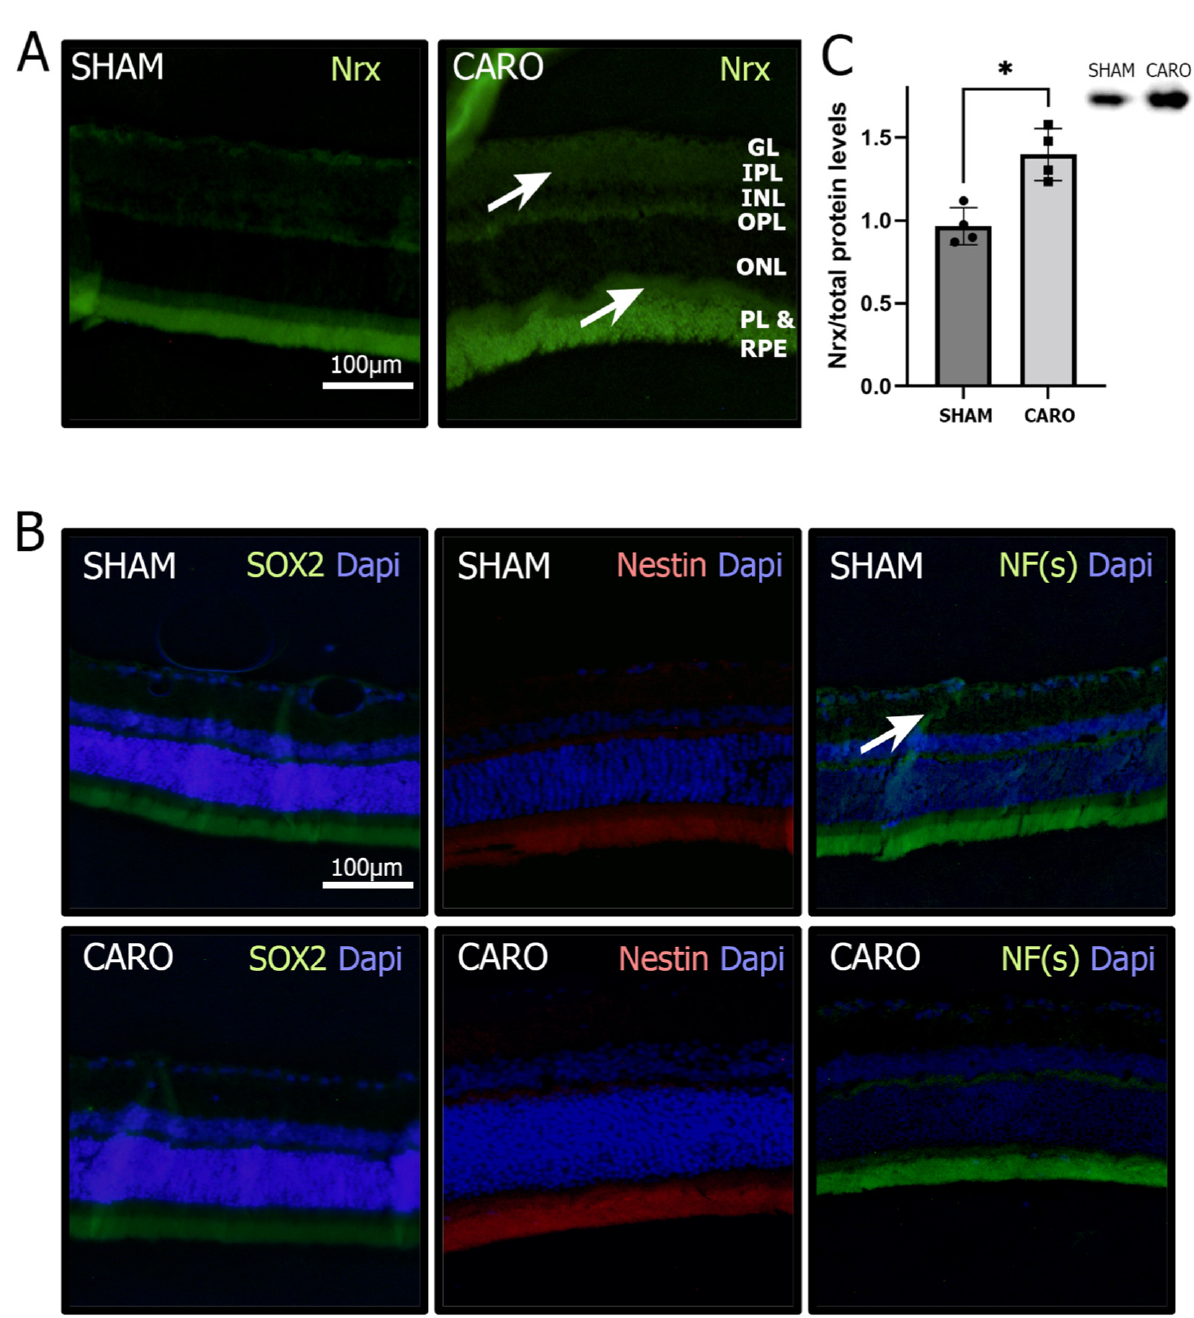
Figure 1. Changes in the retina due to H-I. ( A ). Immunofluorescence staining for Nrx (green) and Dapi counterstaining (blue) in SHAM and CARO retinas. White arrows show increased immunolabeling ( B ). Immunofluorescence staining for differentiation markers: SOX2 (green), Nestin (red), NF(s) (green) and Dapi counterstaining (blue) in SHAM and CARO retinas. White arrow shows increased immunolabeling ( C ). Nrx levels in retinas exposed to H-I (CARO group) and control conditions (SHAM) analyzed using immunofluorescence (Nrx in green) and Western blot ( p = 0.0286; n = 4). Bars and error bars represent the mean + standard deviation (SD) and the asterisk represents a significative difference.